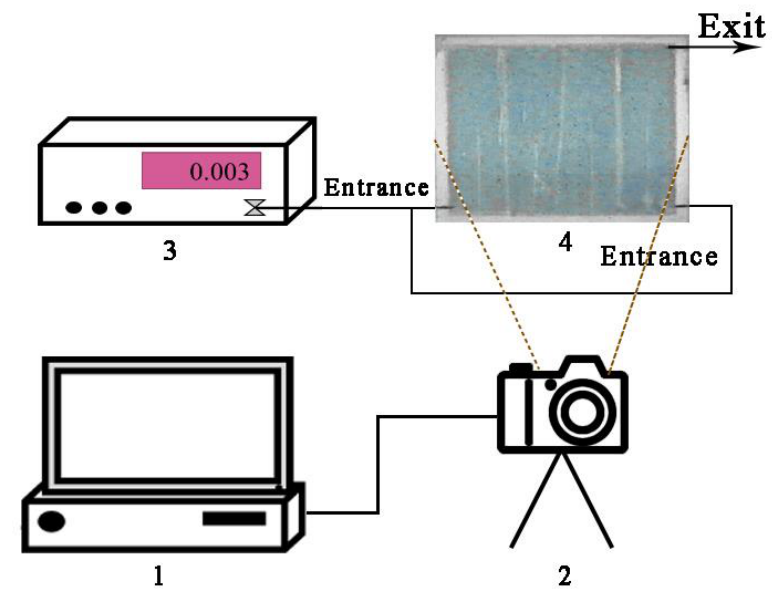
Figure 3. Schematic of visual physical simulation model: 1 — computer, 2 — video camera system, 3 — syringe pump, and 4 — model.